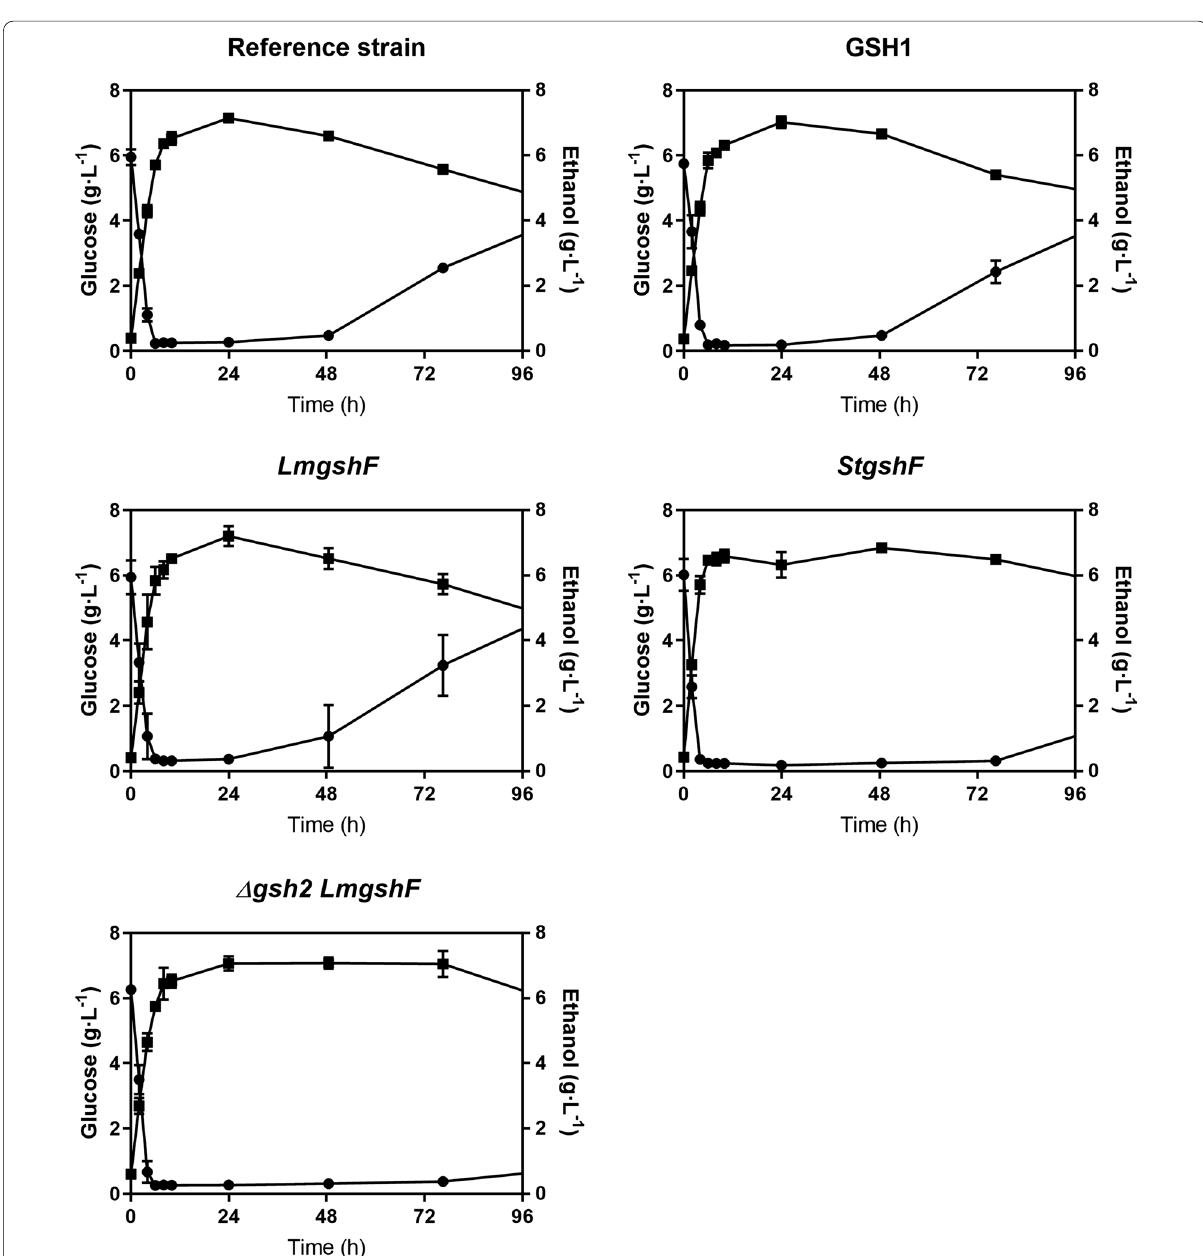
Fig. 2 The time course of glucose (filled circles) and ethanol (filled squares) concentrations with the Saccharomyces cerevisiae strains investigated in the present study with spruce hydrolysate containing 5% WIS content and an initial dry cell biomass concentration of 4 g L − 1 using 20 mg enzyme preparation per g solids at 35 °C and 150 rpm. The data are the means and standard deviation (n =